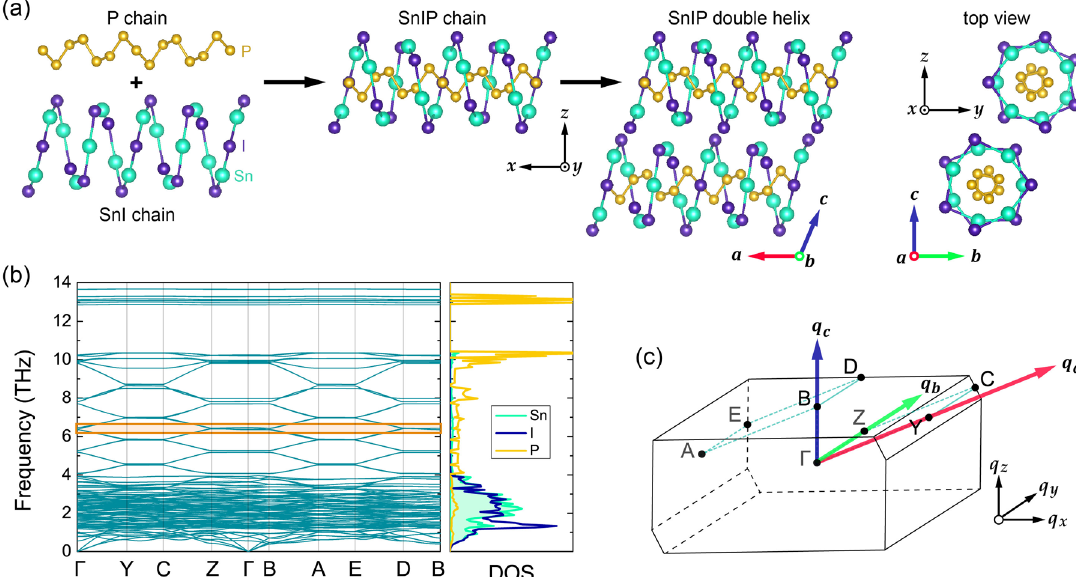
Fig. 2 Structural and vibrational properties of SnIP. a Crystal structure, b phonon dispersion and c Brillouin zone of SnIP. The orange region in the phonon dispersion highlighted in ( b ) corresponds to the topological features that we focus on. The phonon DOS is also shown in ( b